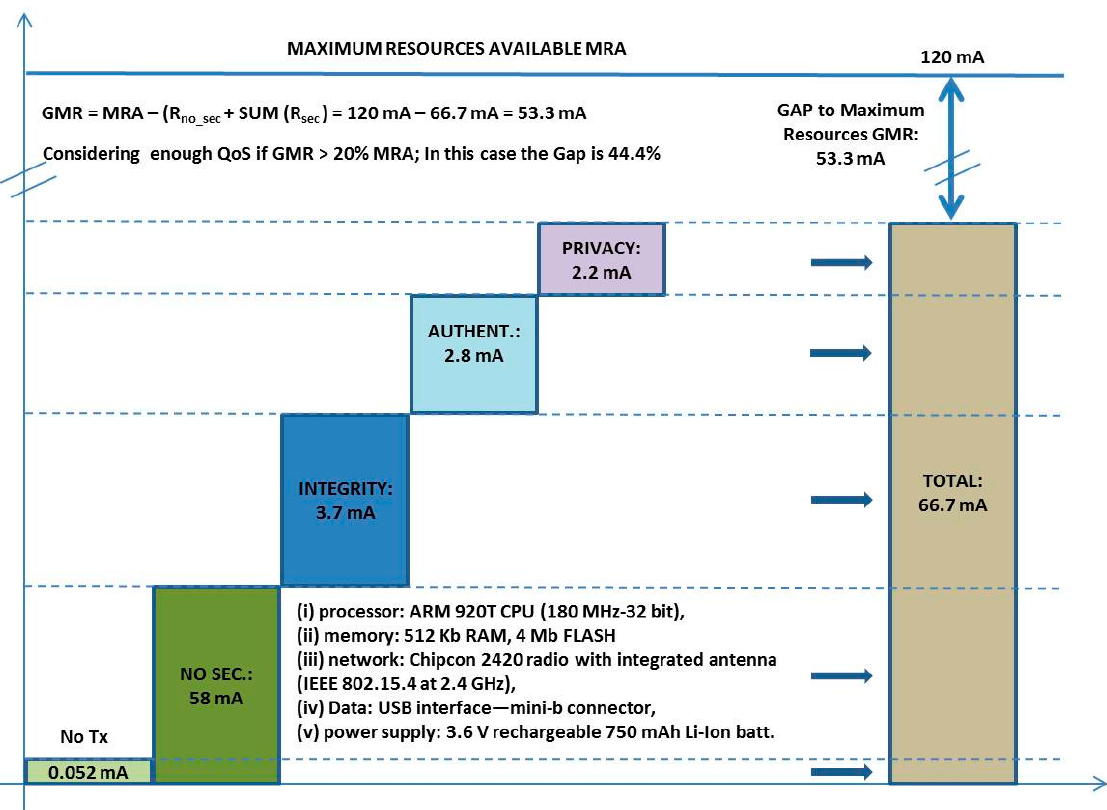
Figure 13. Energy spent vs. security services.